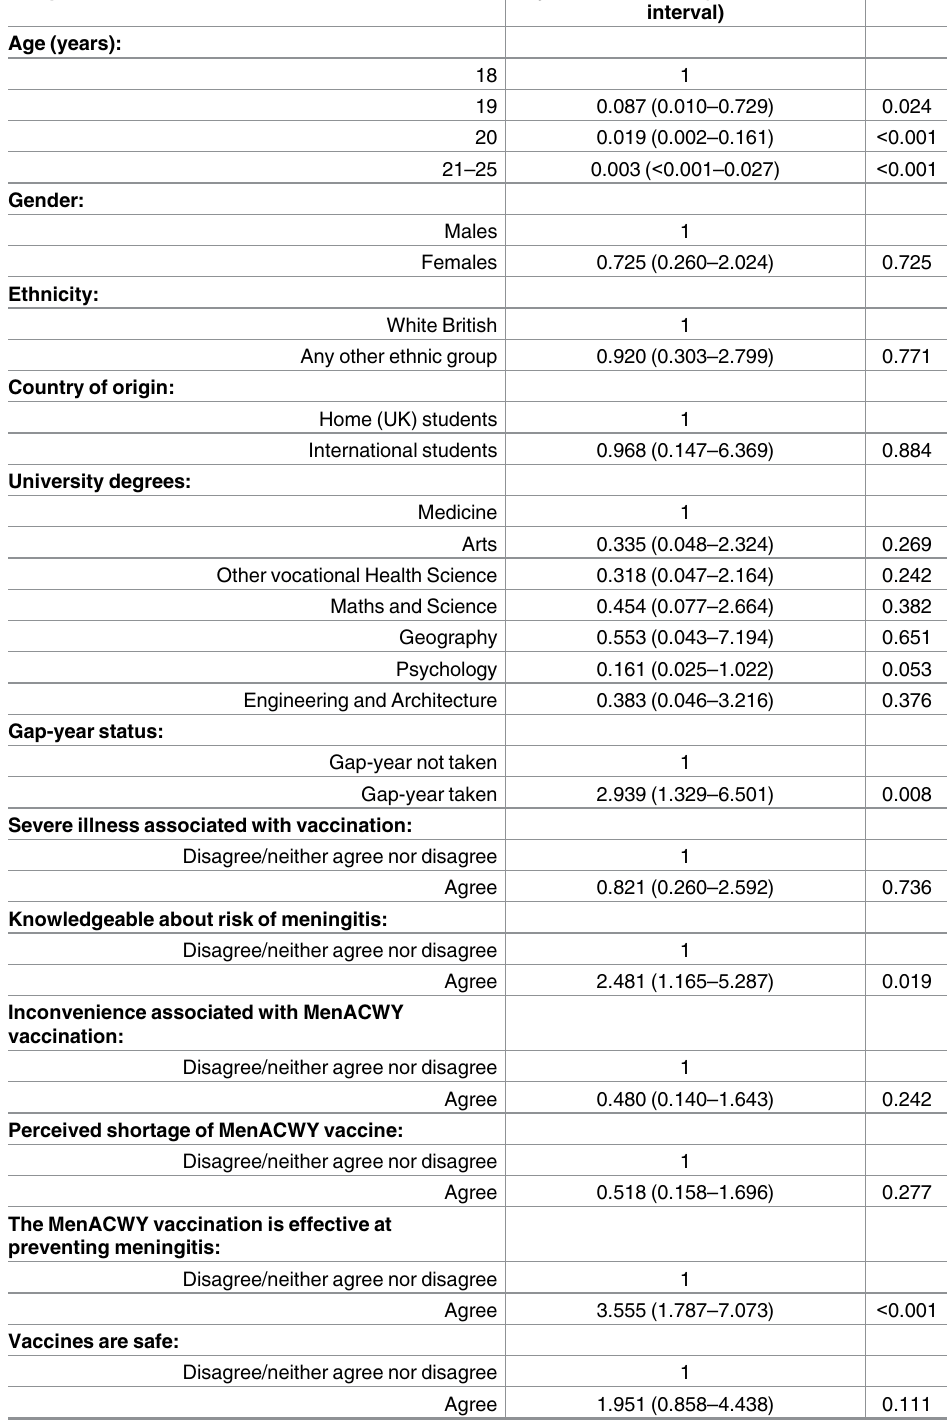
Table 4. Multivariable logistic regression analysis of the associations between health beliefs, demo- graphic variables and vaccination. Independent